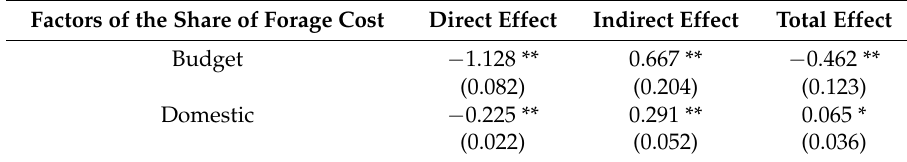
Table 3. Estimated direct and indirect effects of government spending and domestic forage production on cost share of forage in the path analysis